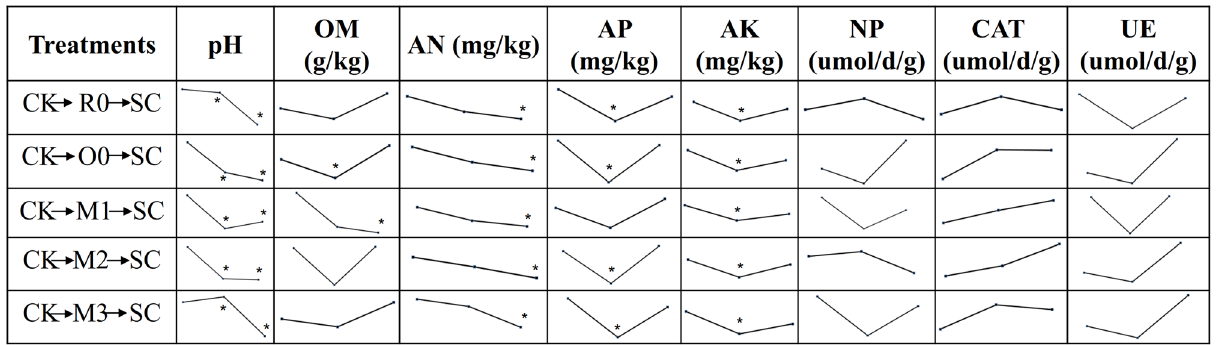
Figure 5. The change tendency in soil physicochemical properties in the ARMR system. The asterisks indicated the significant differences of soil bacteria α-diversity indices between preceding crop/successive crop and CK with the level of P =